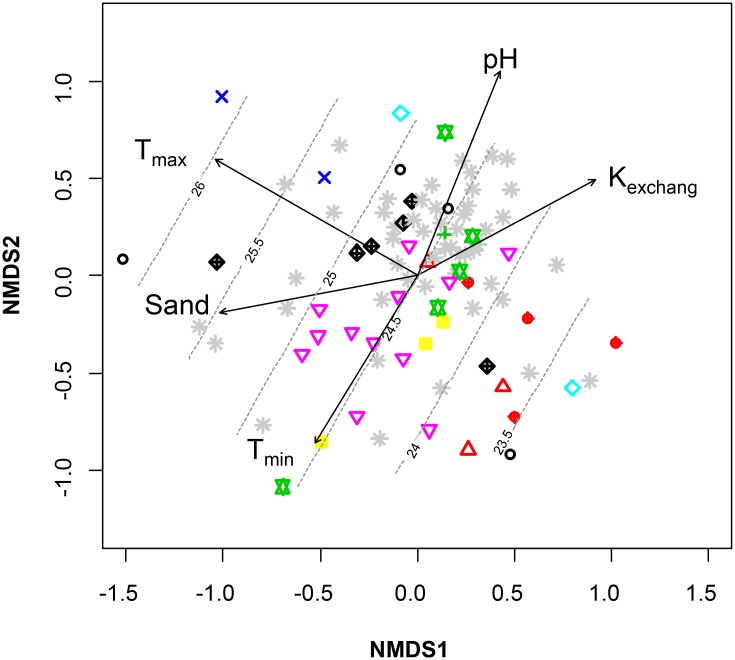
NMDS biplot of a Bray-Curtis dissimilarity matrix of nematode community analysis.The fitted vectors of environmental variables (soil physicochemical and climatic) and the agronomic variable olive cultivar (each of the 11 olive cultivars is shown with different symbols) that were most significantly and strongly associated (P < 0.05) with the ordination and shown in Table 2 are also represented (a generalized additive model fitted contours show also maximum temperature (Tmax) ramp (ºC).